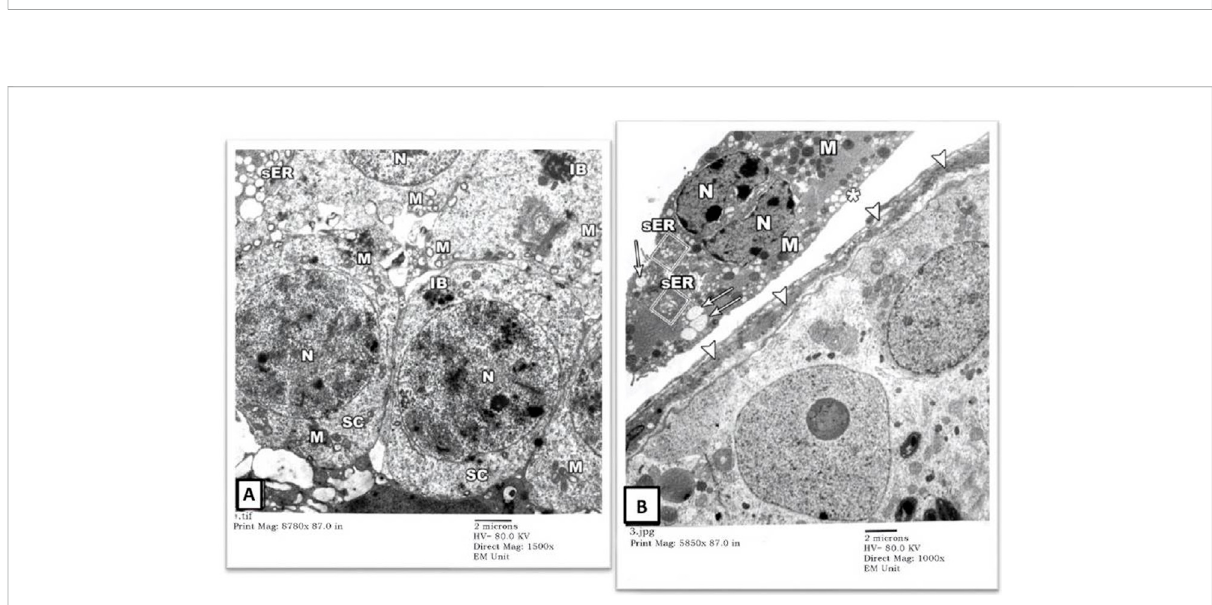
FIGURE 6 An electron micrograph of the testis from a rat in the Gin-treated group showing: (A) a part of seminiferous tubule displaying spermatocytes (SC). Their cytoplasm contains mitochondria (M) and also electron-dense granules (IB). These cells simulate those of the control animals. (Uranyl acetate and lead citrate X 1500, Print Mag. X 8780). (B) the interstitium was exhibiting Leydig cell (Asterisk) with vivid nucleus (N), lipid droplets (arrows), mitochondria (M), and sER (inside rectangles). (Uranyl acetate and lead citrate X 1000, Print Mag. X